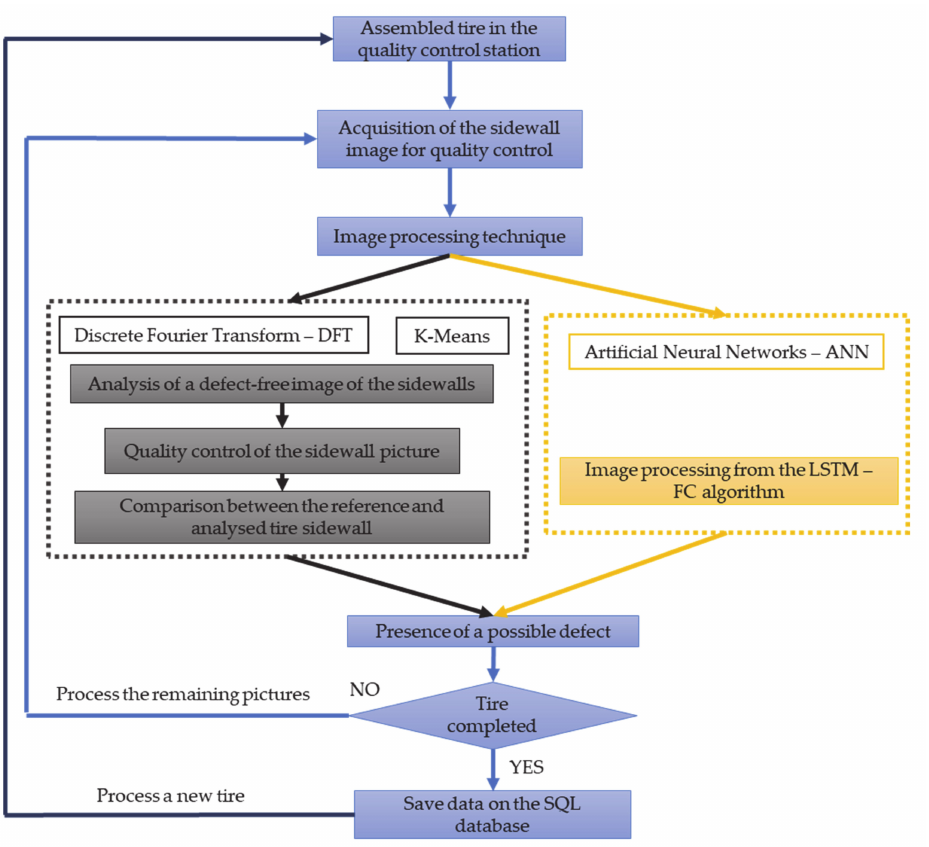
Figure 4. Flowchart describing the methodological approach followed from the present